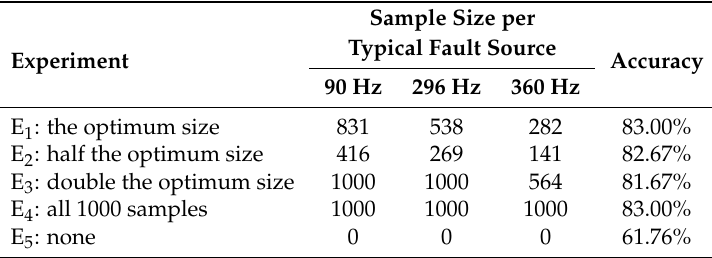
Table 1. Accuracies of different expanded sample sizes.